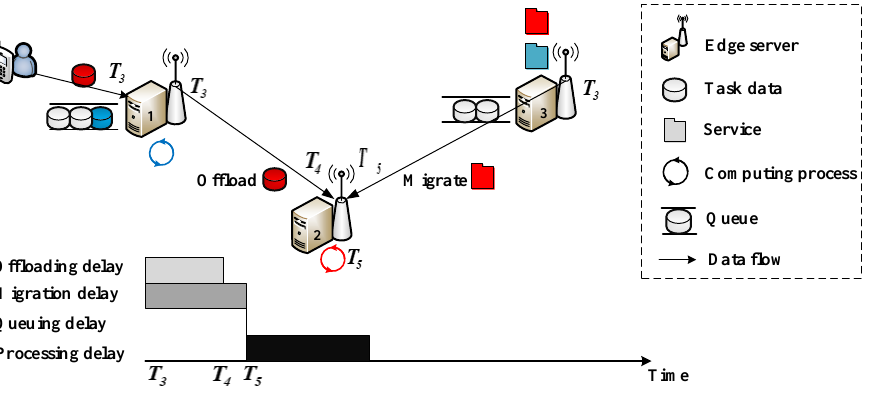
Figure 3. Task processing for dynamic computation offloading